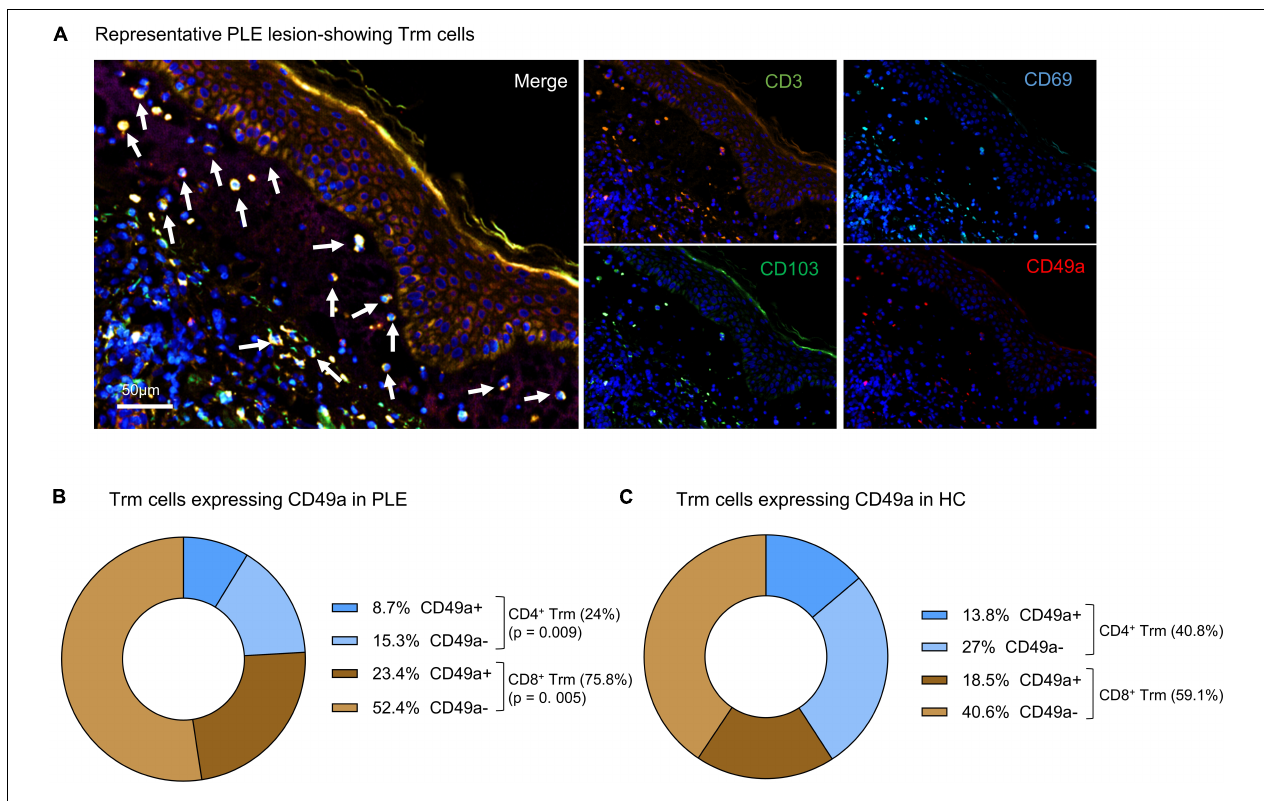
FIGURE 2 | Skin Trm cells of PLE lesions express CD49a. (A) Representative image of immunofluorescent staining of a PLE section; arrows indicate CD3 + CD69 + CD103 + CD49a + Trm cells localized in the dermis and near the dermo-epidermal junction. (B) Percentage of CD4 + or CD8 + tissue residency marker distribution on T cells in PLE lesions and in panel (C) HC skin expressing CD49a is shown in the pie charts; data shown as a mean percentage of all tissue-resident T cells from immunostaining data. Statistical analysis with Mann–Whitney test, (HC: n = 11, PLE: n = 13).